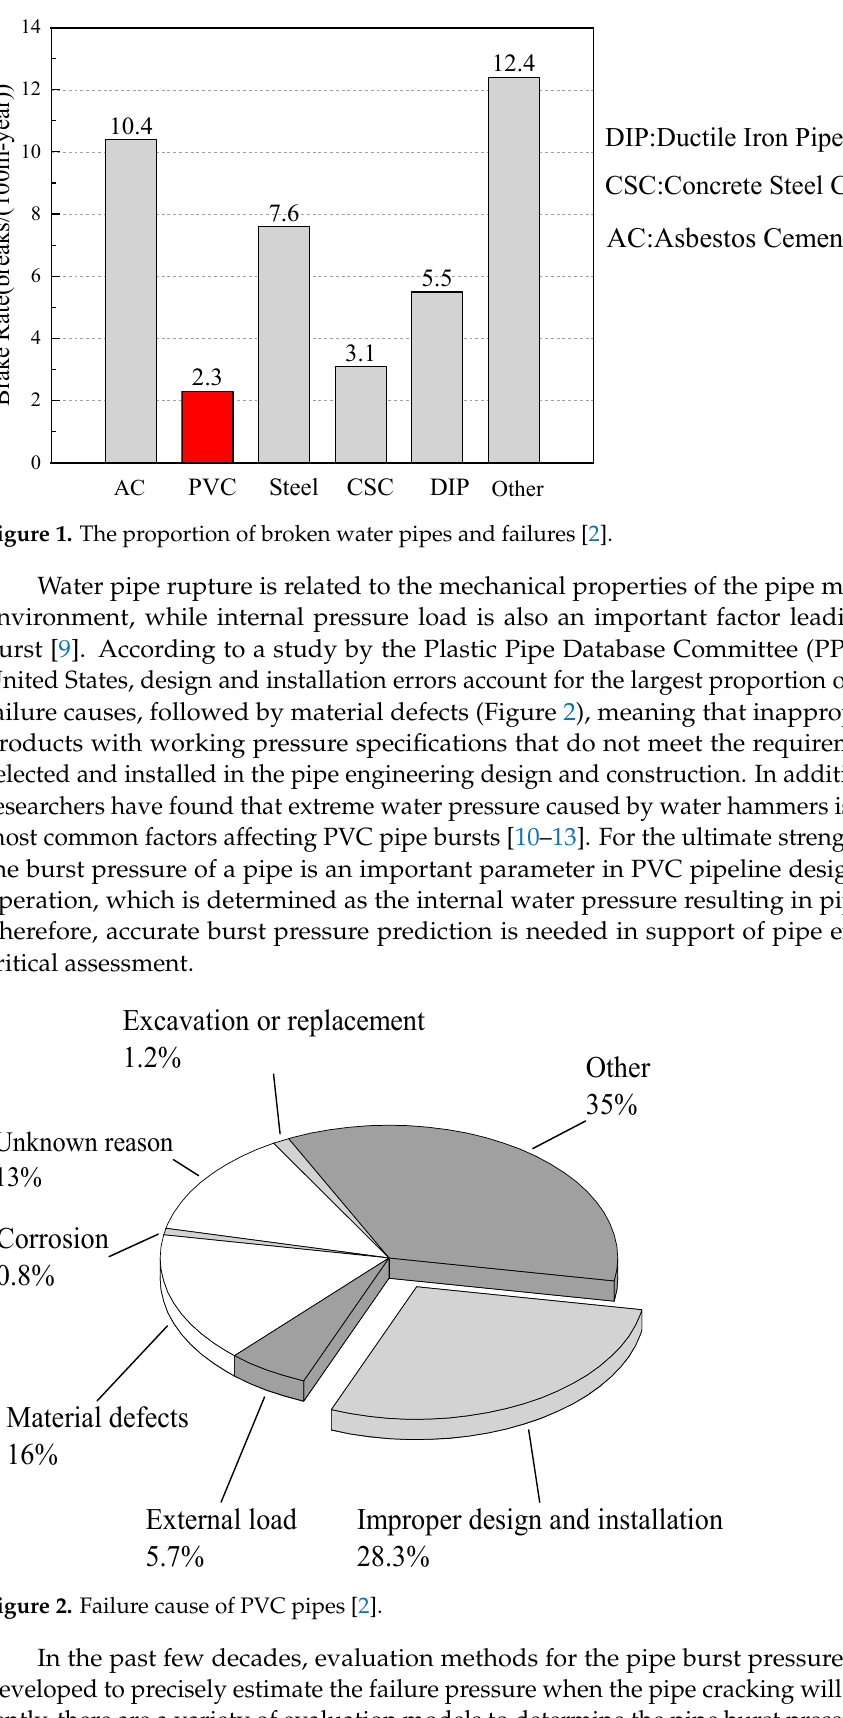
Figure 1. The proportion of broken water pipes and failures [2].